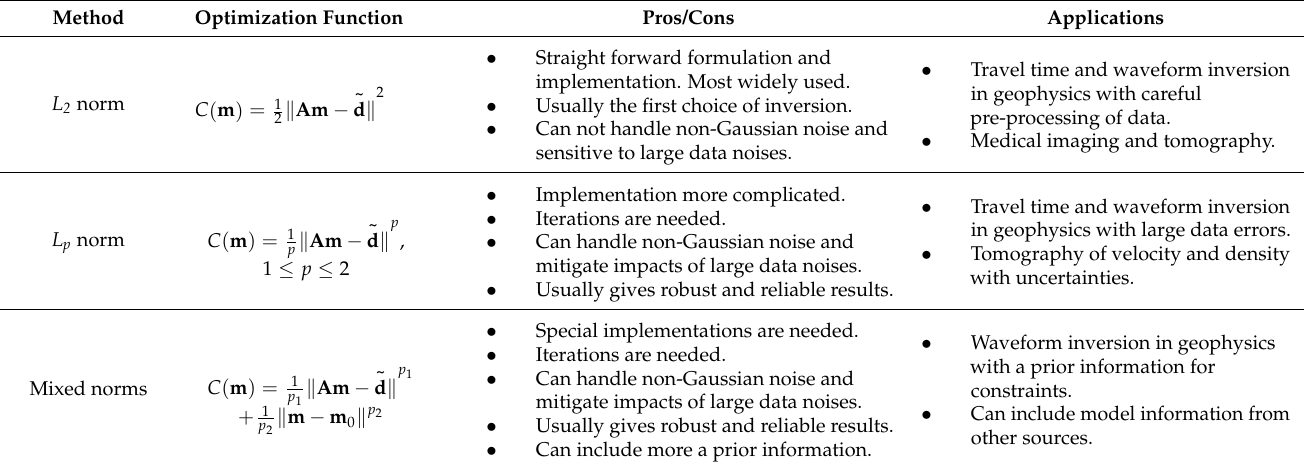
Table 1. Comparison of different inversion